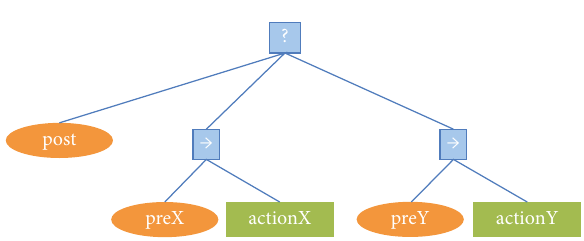
Figure 6: Postcondition-precondition-action (PPA) pattern subtree.